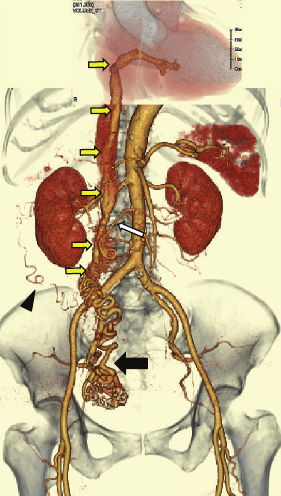
Figure 1: Three-dimensional arterial phase volume-rendered CT image indicated dilation of the right uterine artery (black arrow). Several small arteries originating from the right uterine artery were considered to be tumor arteries because they extended to the IVC through the right ovarian vein and then extended into the right atrium and the right ventricle (yellow arrows). A plexus of small arteries which comprised complex vascular formations originating from the right ovarian artery (white arrow), the right subcostal artery (arrowhead), and the right uterine artery surrounded tumor arteries along the route of the right ovarian